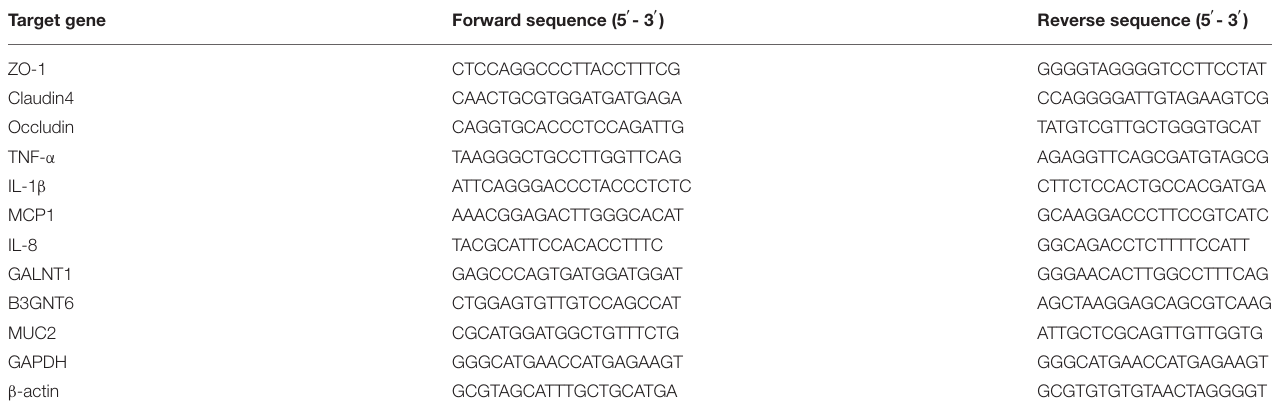
TABLE 2 | The nucleotide sequences of primer. Target